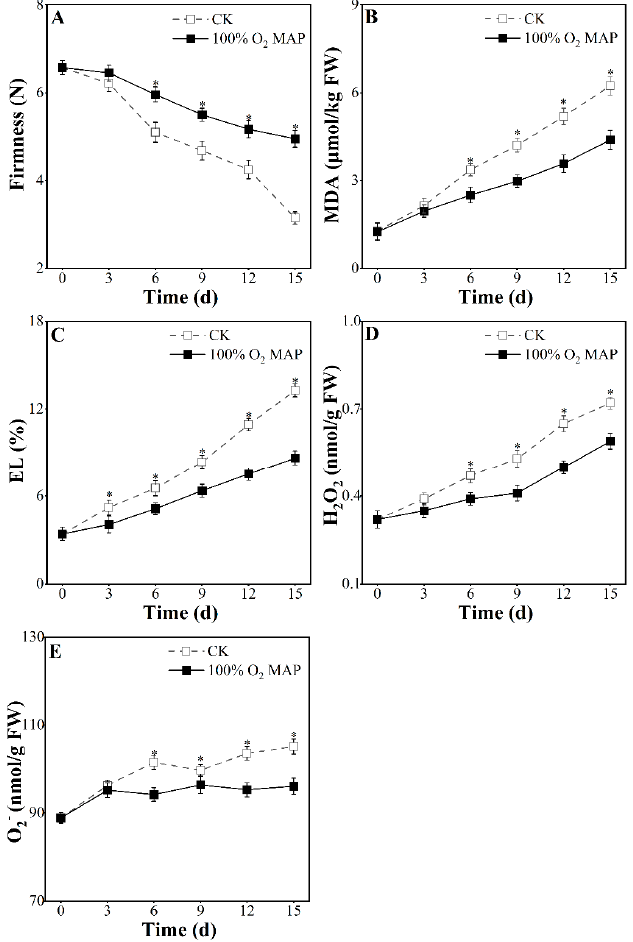
Figure 6. E ff ect of 100% O 2 MAP on fi rmness ( A ), MDA ( B ), EL ( C ), H 2 O 2 ( D ), and O 2- ( E ) of fresh- Figure 6. Effect of 100% O 2 MAP on firmness ( A ), MDA ( B ), EL ( C ), H 2 O 2 ( D ), and O 2 − ( E ) of cut broccoli. fresh-cut broccoli. * in the figure indicates significant differences among treatments at the same storage time ( p <